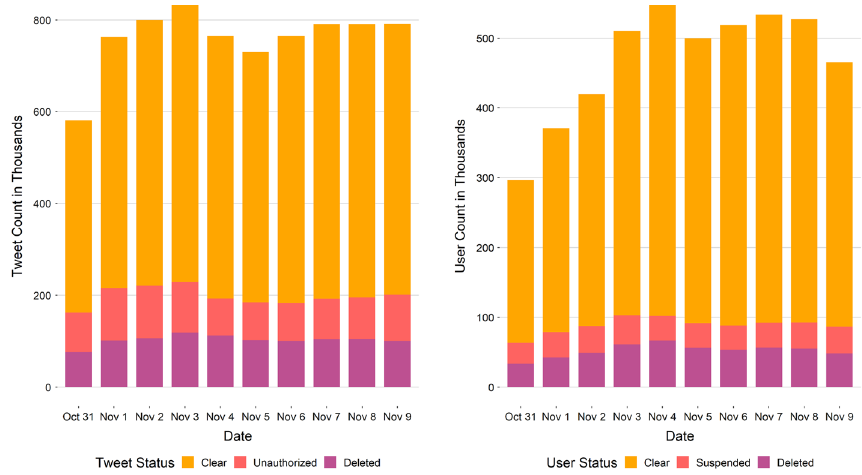
Fig. 2 a Count of tweets per tweet status type per day. b Unique number of twitter users per user status type per